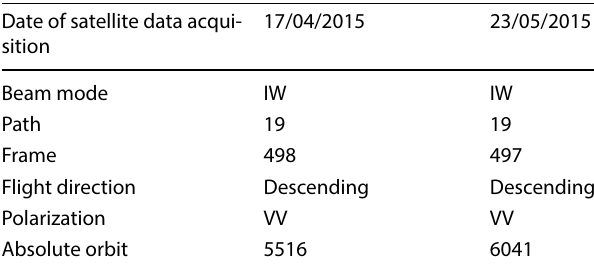
Table 1 Description of satellite images of Central Nepal